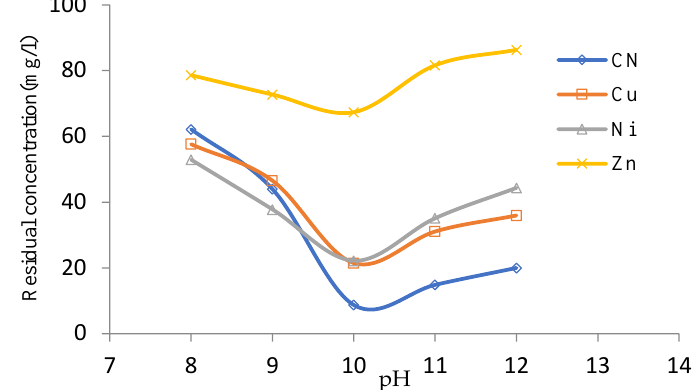
Figure 8. Effect of pH on (PEC) PH process for simultaneous removal of pollution.